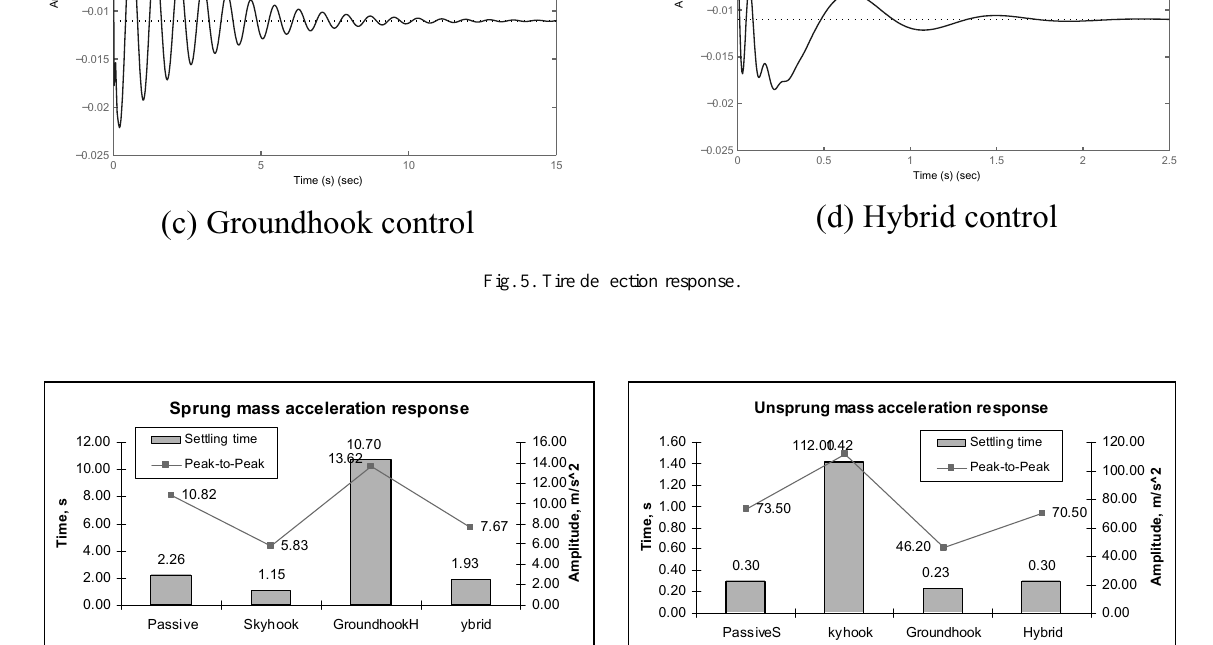
Fig. 6. Summary of results for sprung mass and unsprung mass acceleration